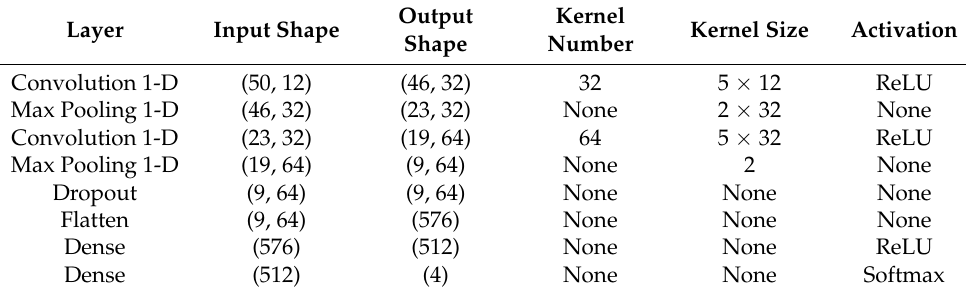
Table 2. The details of the proposed CNN